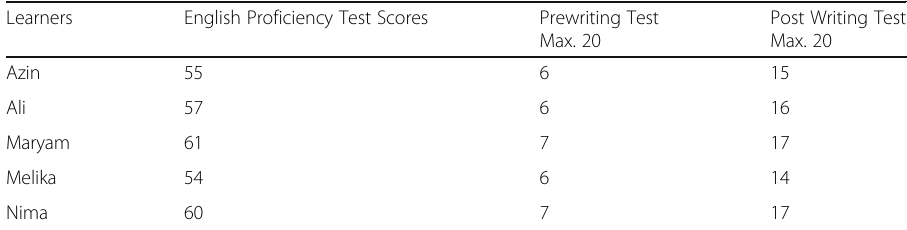
Table 5 Participants ’ scores on